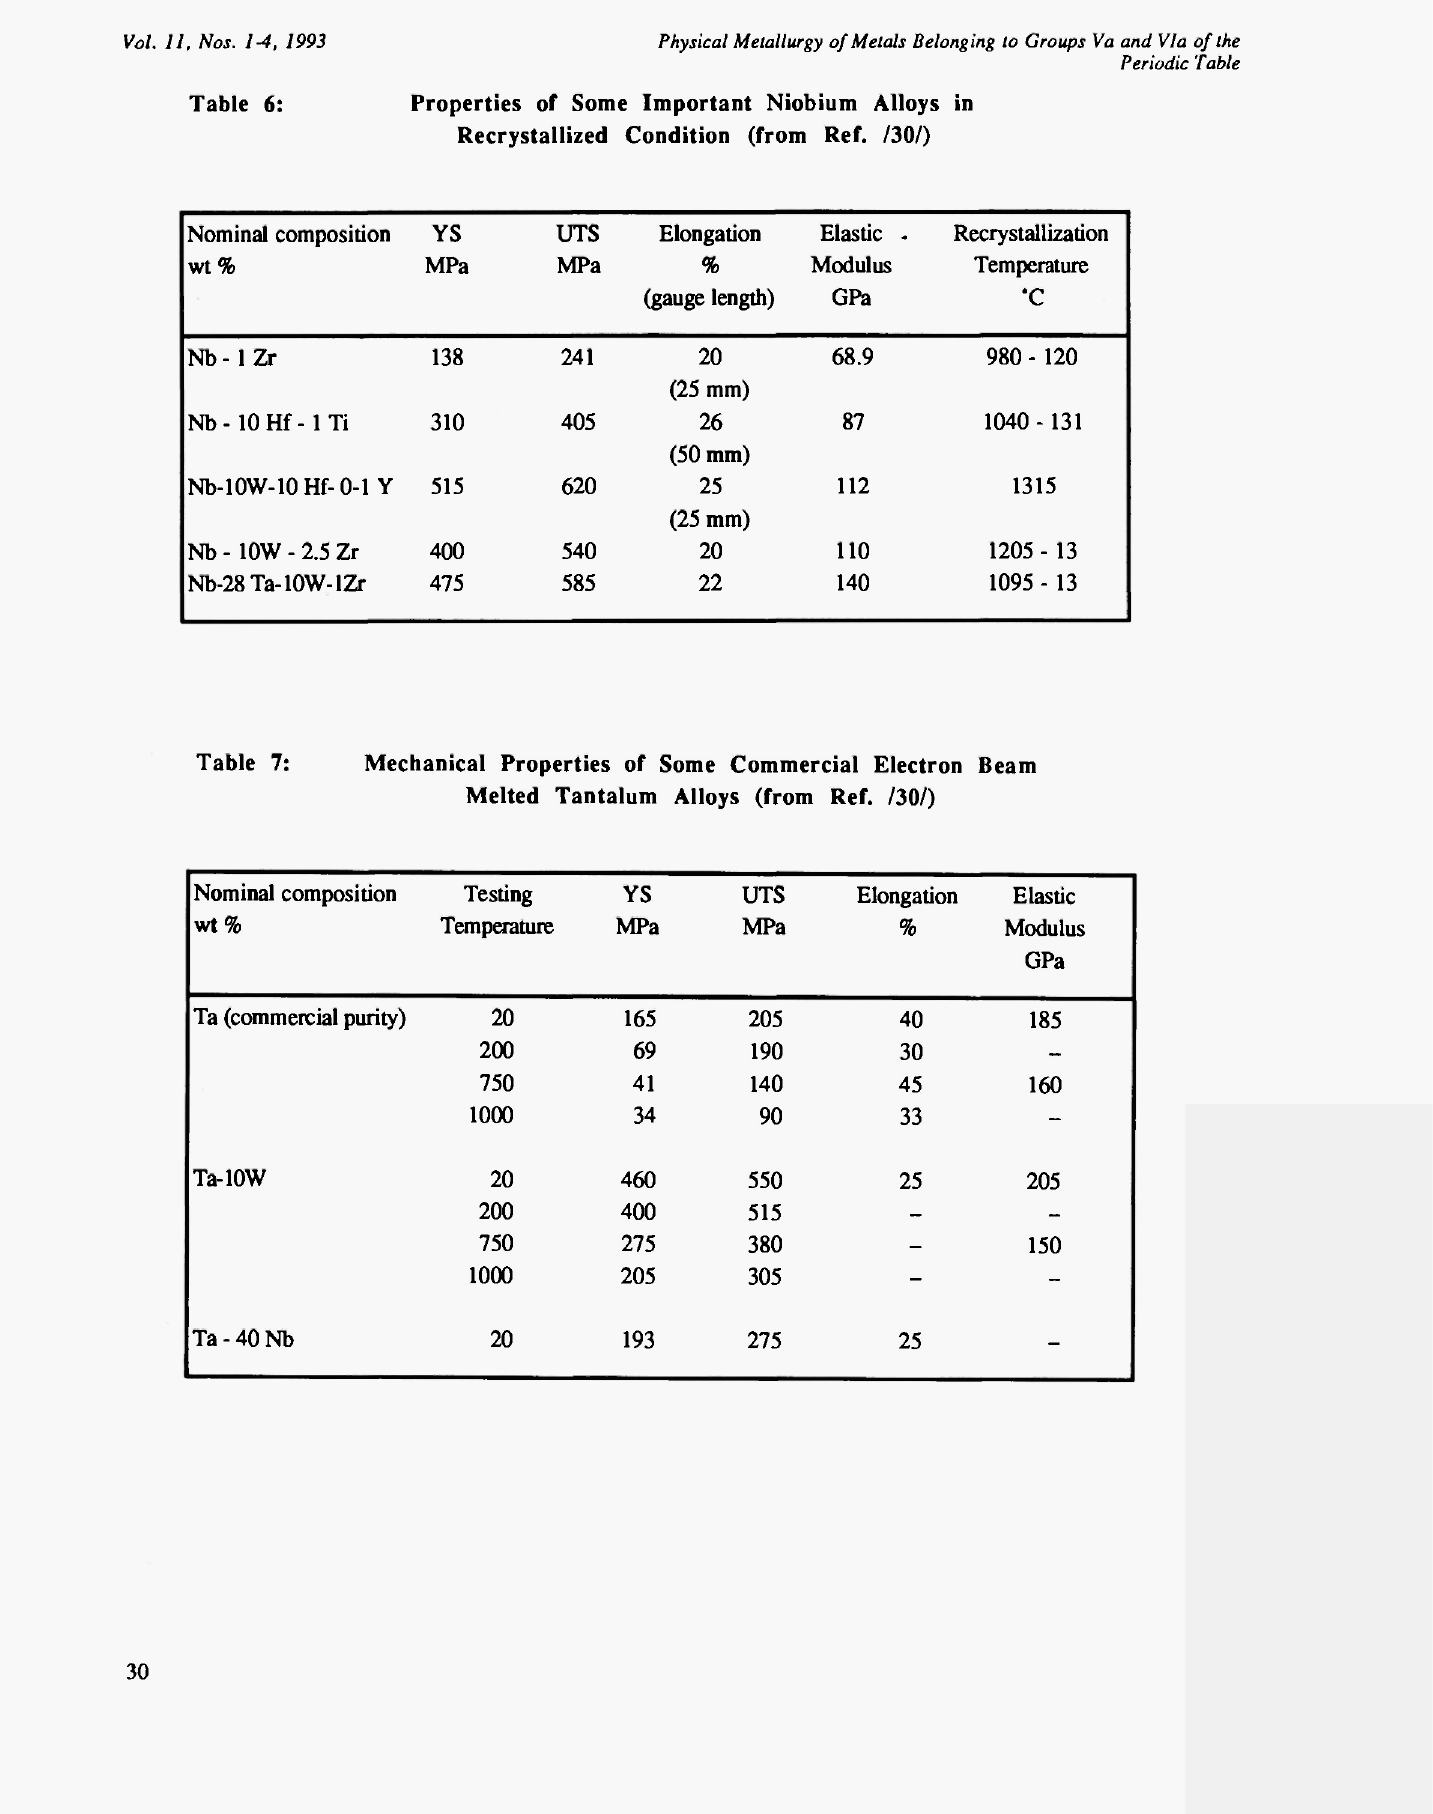
Mechanical Properties of Some Commercial Electron Beam Melted Tantalum Alloys (from Ref.